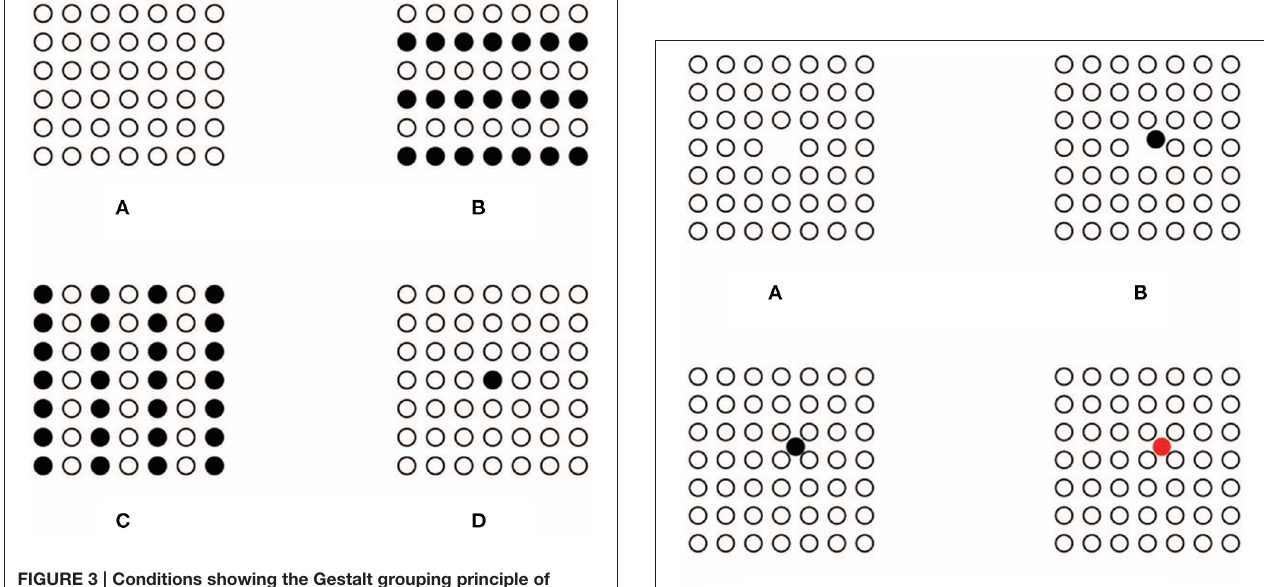
FIGURE 3 | Conditions showing the Gestalt grouping principle of similarity. Small squares group together in a large square shape (A) . Similarity is responsible for grouping element components in rows (B) . Similarity is responsible for grouping element components in columns (C) . Only one circle is segregated from the others (D) .